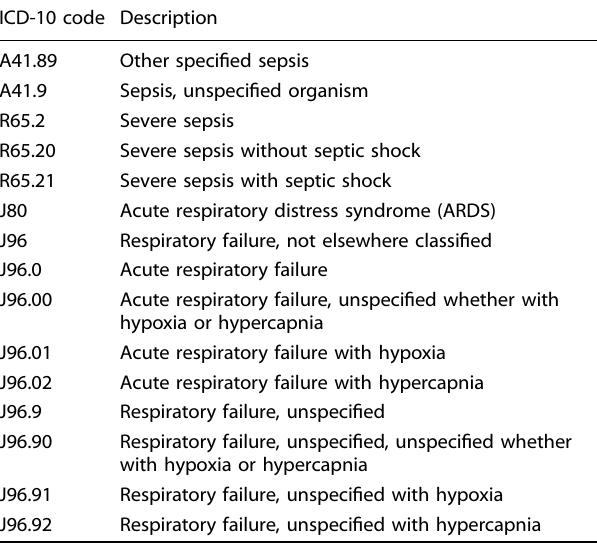
Table 4. ICD-10 codes for the prediction